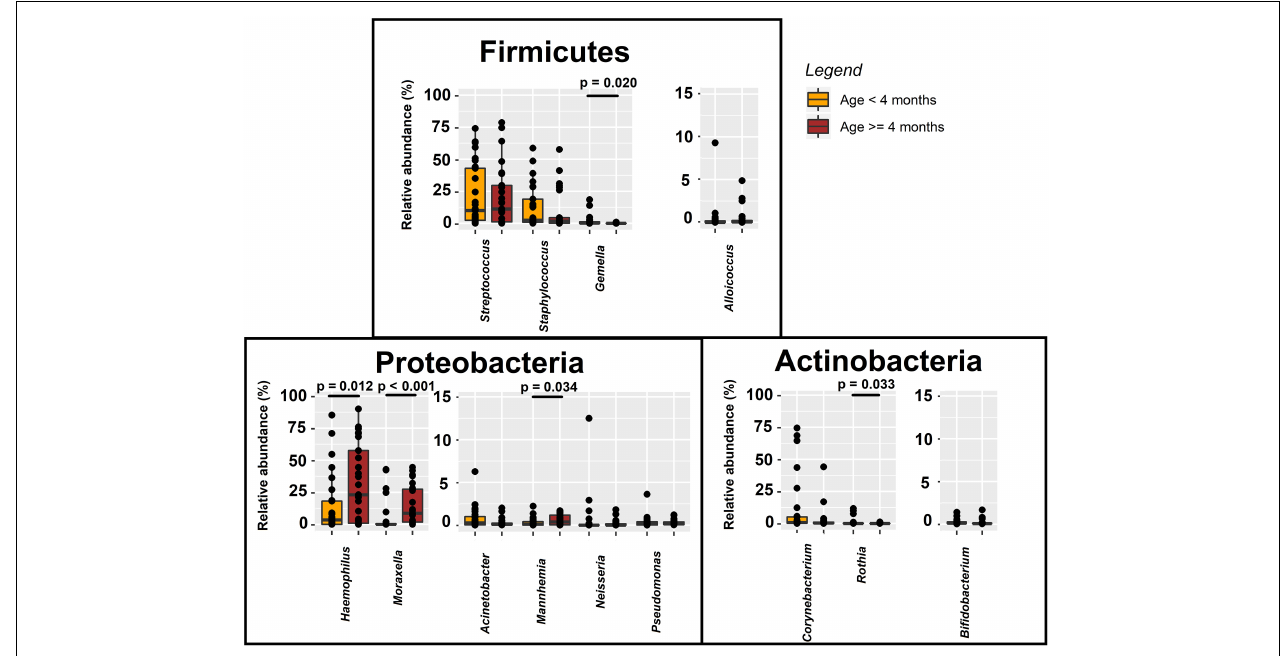
FIGURE 7 | Relative abundance of phylum- and genus-level sequences in nasal samples from bronchiolitis infants aged < 4 years ( n = 29; orange) and ≥ 4 years ( n = 29; red). Significant differences between samples from both groups of infants are indicated (Wilcoxon rank sum tests).